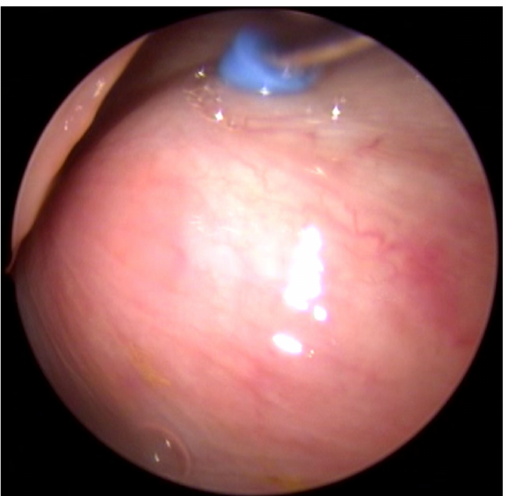
Figure 6. Endoscopic view of the ET of in vivo case 12 after injection of HA. A bulge is clearly visible in the ventro-rostral area of the tube (compare Figure 2). The insertion instrument is still in place.